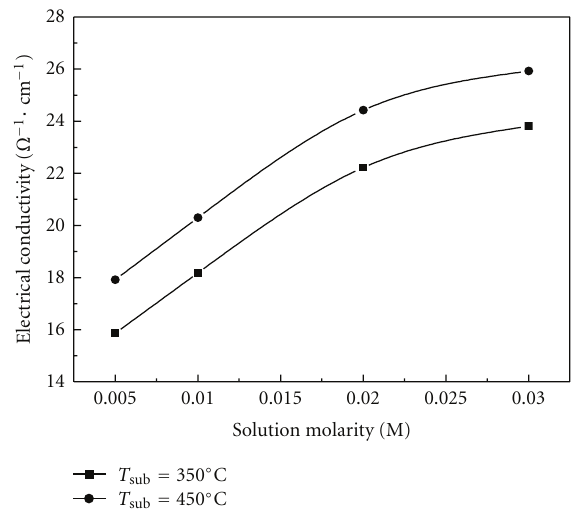
Figure 4: The dark electrical conductivity of IrO 2 thin film as a function of solution molarity at di ff erent substrate temperatures.